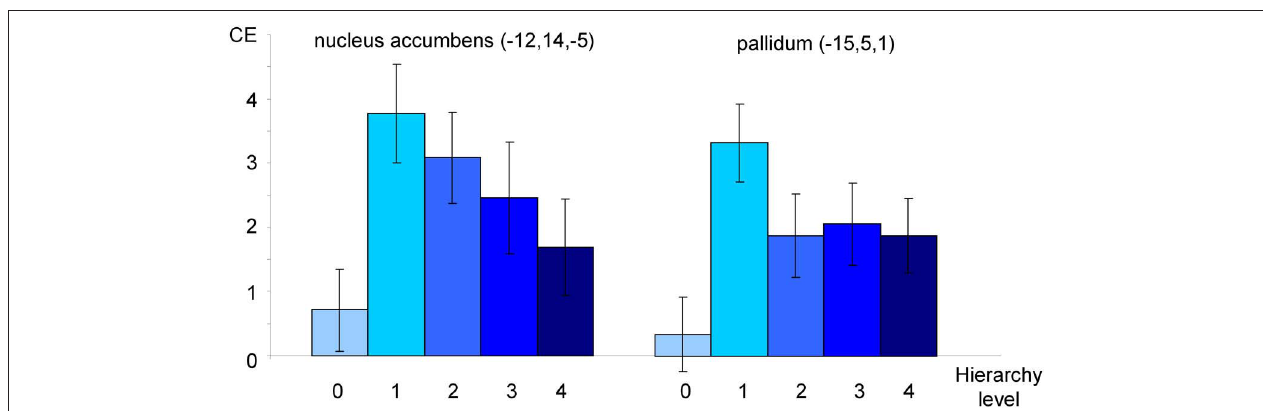
FIGURE 5 | Neural activation of patients toward individualized pictures plotted against hierarchy levels. Mean contrast estimates (CE; and standard errors of the mean) in peak voxels in nucleus accumbens and